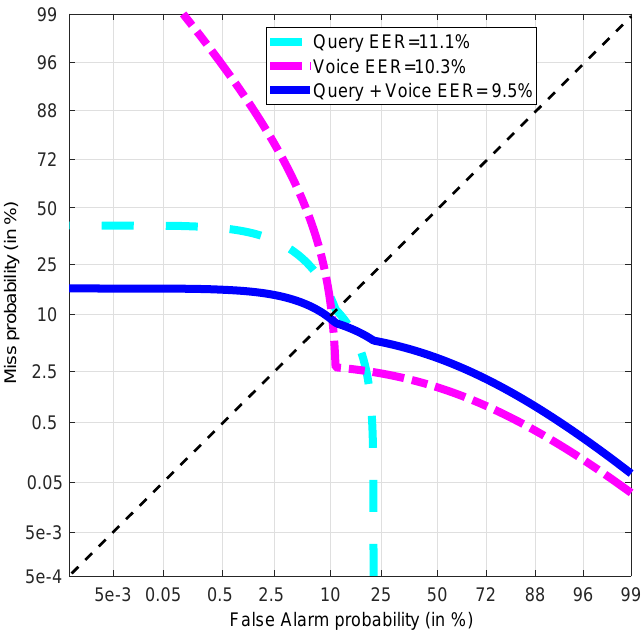
Figure 3. DET (Detection error trade-off) curves and EER (Equal error rate) for unseen voice and query data.